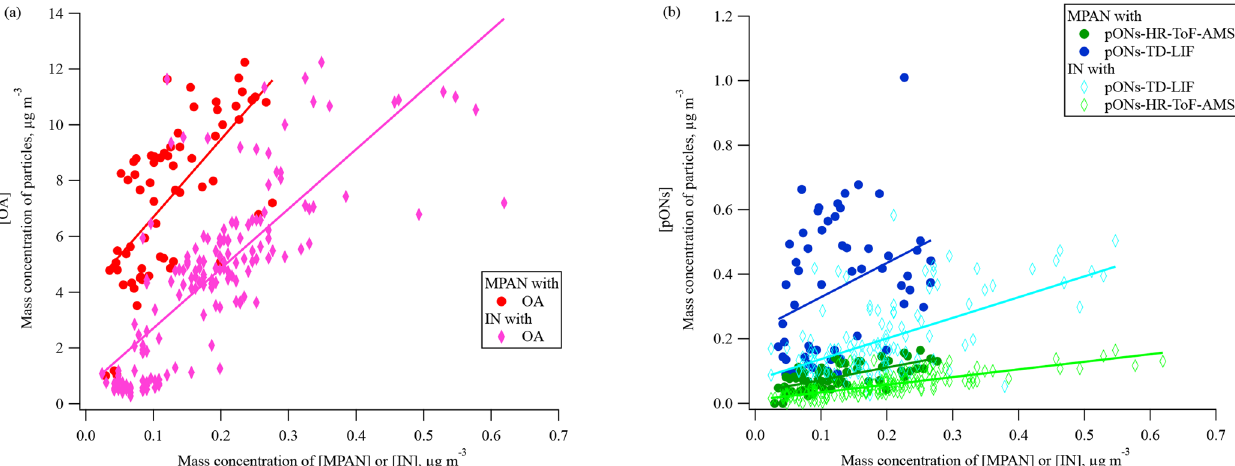
Figure 7. The relationship between mass of MPAN or IN in the gas phase and in organic aerosol during the daytime 29 June–15 July (the time period when data on pONs-TD-LIF were available). (a) OA is organic aerosol (without organic nitrate) and (b) pONs is particle-phase organic nitrates. MPAN has a linear slope ( R 2 ) of 27.8 (0.455) vs. OA, 0.4 (0.437) vs. pONs-HR-ToF-AMS, and 1.1 (0.120) vs. pONs-TD-LIF. IN has a linear slope ( R 2 ) of 21.4 (0.606) vs. OA, 0.2 (0.603) vs. pONs-HR-ToF-AMS, and 0.6 (0.341) vs.